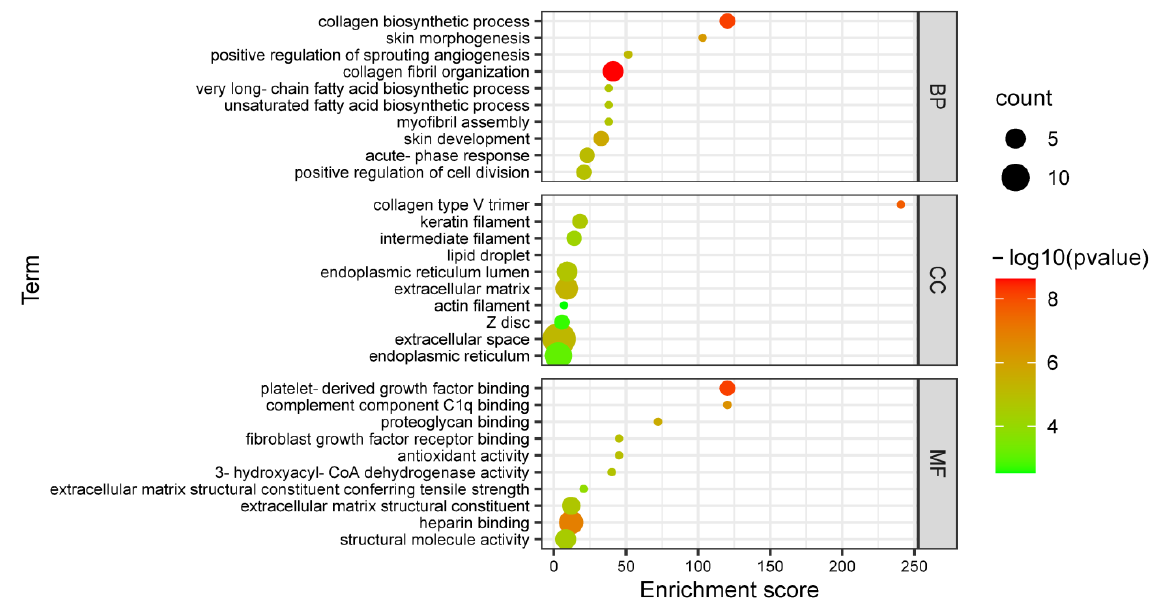
Figure 2. The top 30 items of Gene Ontology (GO) enrichment of differentially expressed proteins (DEPs) in FYs and MYs subcutaneous fat. BP: biological process; CC: cellular component; MF: molecular function.